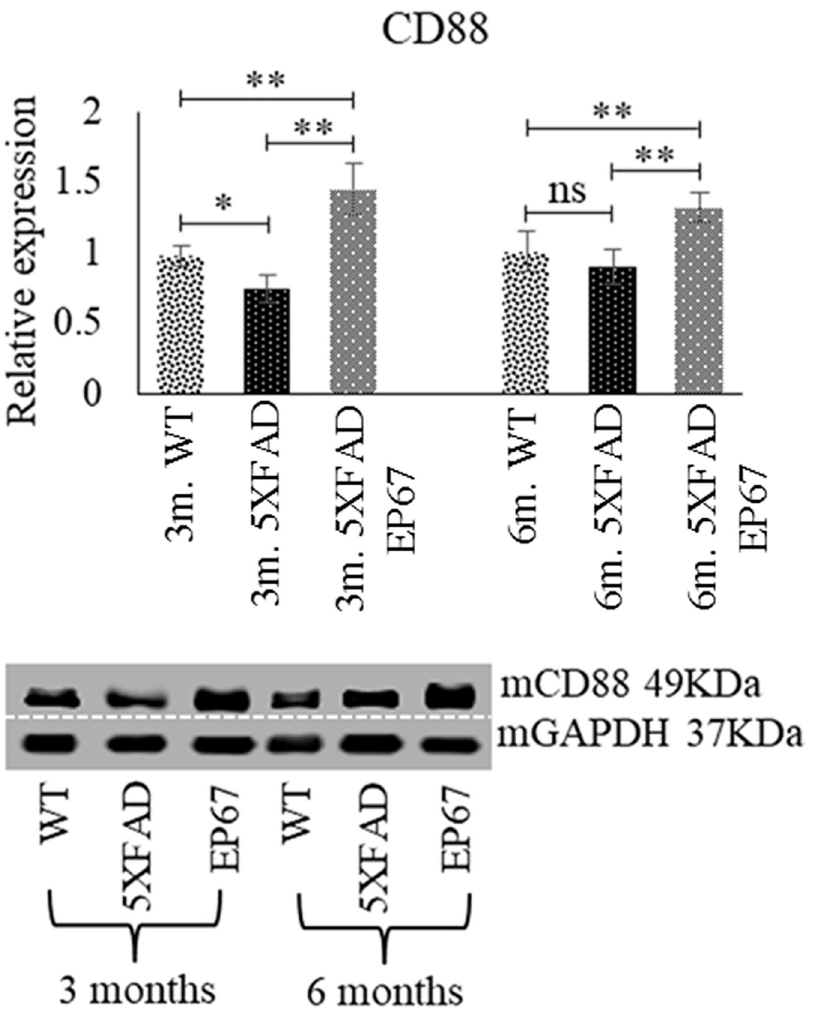
Fig 3. C5aR (CD88) expression. Immunoblot analysis of the CD88 marker revealing increased expression of the receptor in 5XFAD animals treated with EP67, both at 3 months and 6 months compared to both the wild type and untreated 5XFAD animals. (Immunoblot images indicate representative sample runs and were cropped as indicated by the dotted white